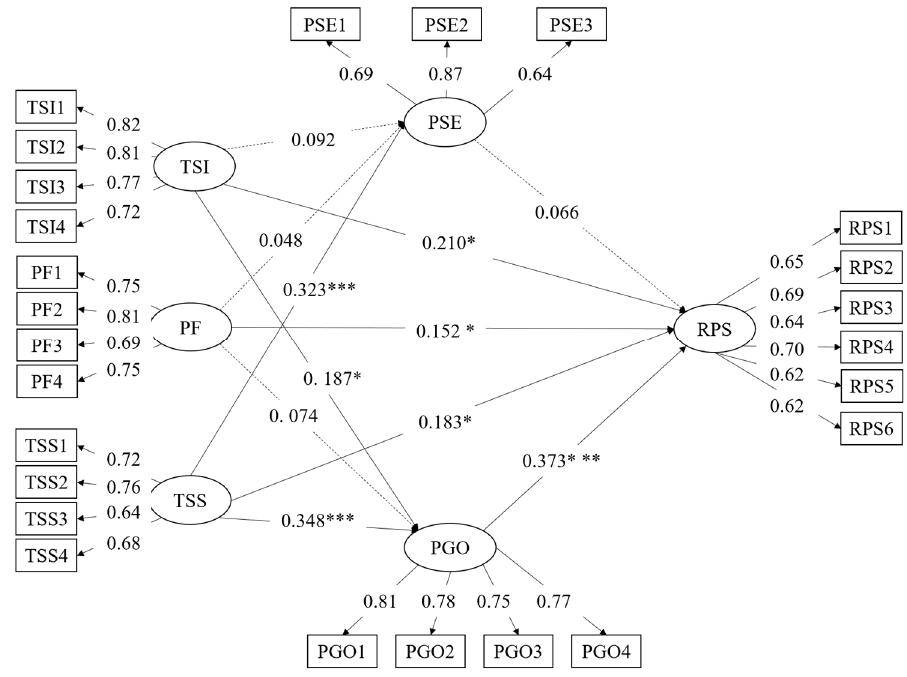
Figure 2. The structural model diagram of teachers’ reflective practice skill. Note: * p < 0.05, *** p < 0.001.